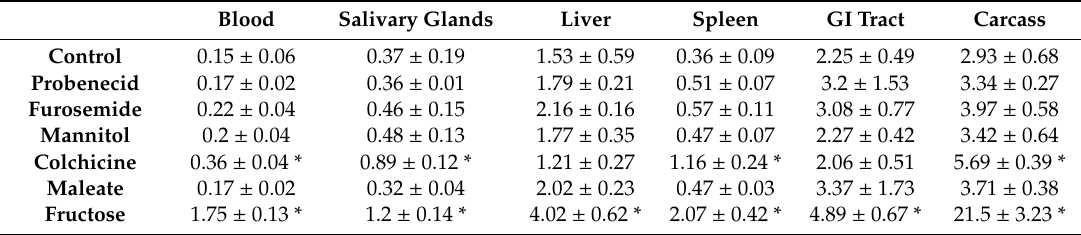
Table 2. Biodistribution of [ 99m Tc]Tc-Z HER2:2395 in NMRI mice 4 h after injection alone (control) or after administration of